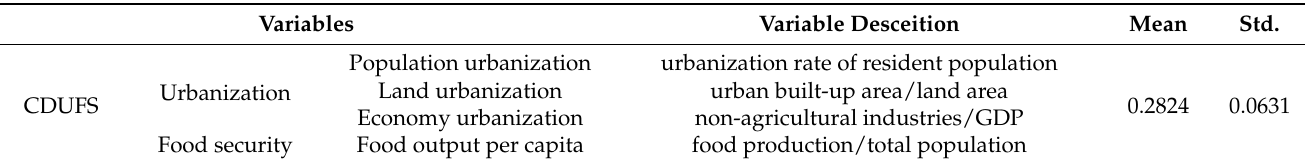
Table 1. Brief descriptive statistics.